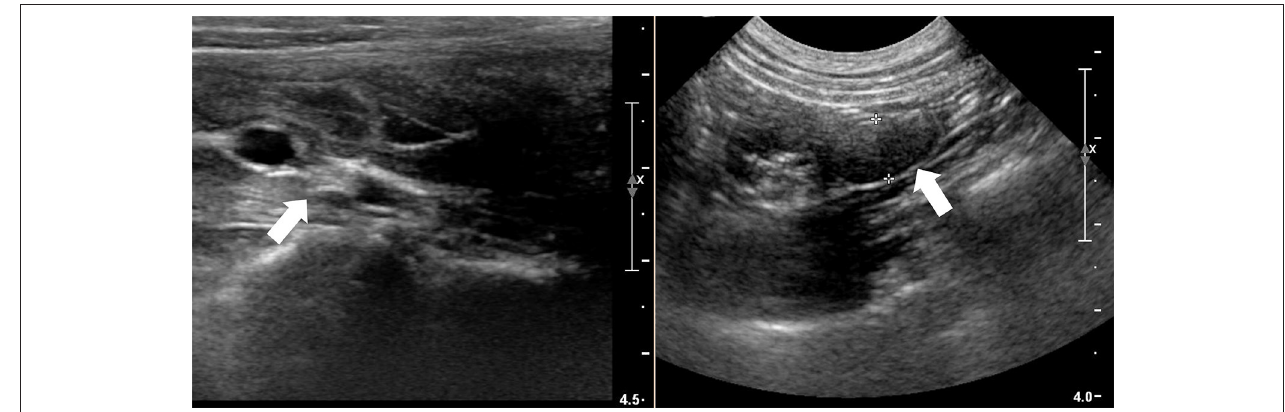
FIGURE 1 | Ultrasound imaging of the cervical thickening at the mass (left arrow) and of the poorly visualized left ovary (right arrow).